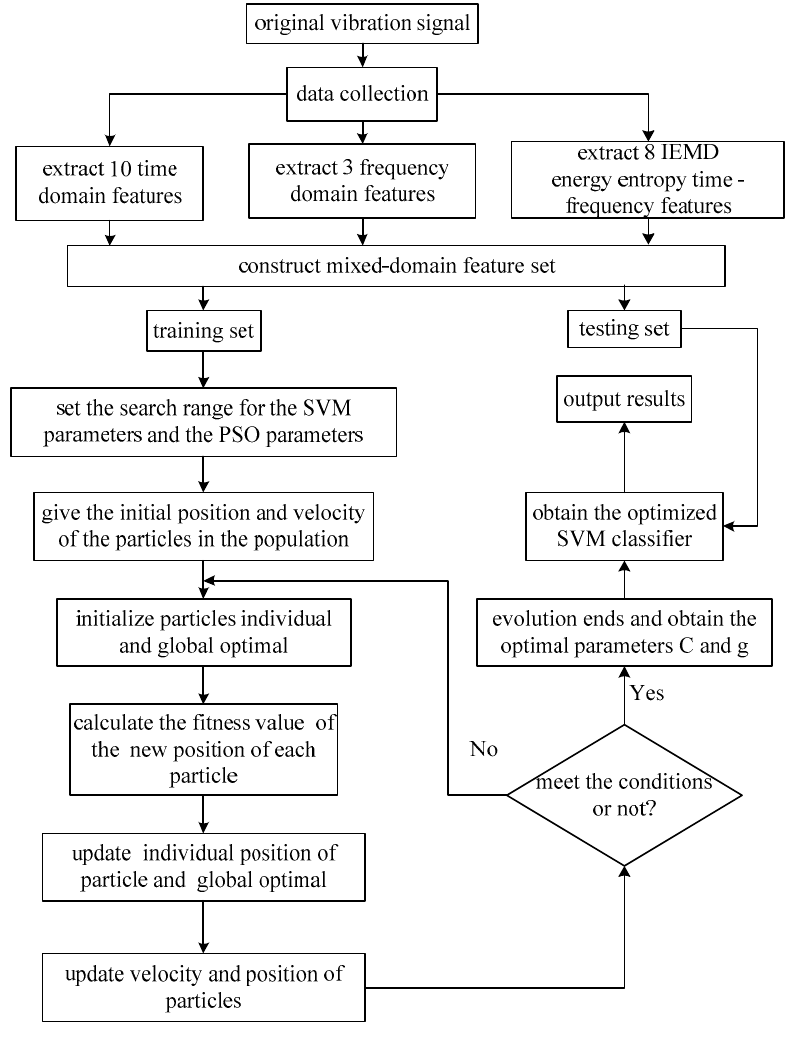
Figure 2. The PSO-SVM fault isolation